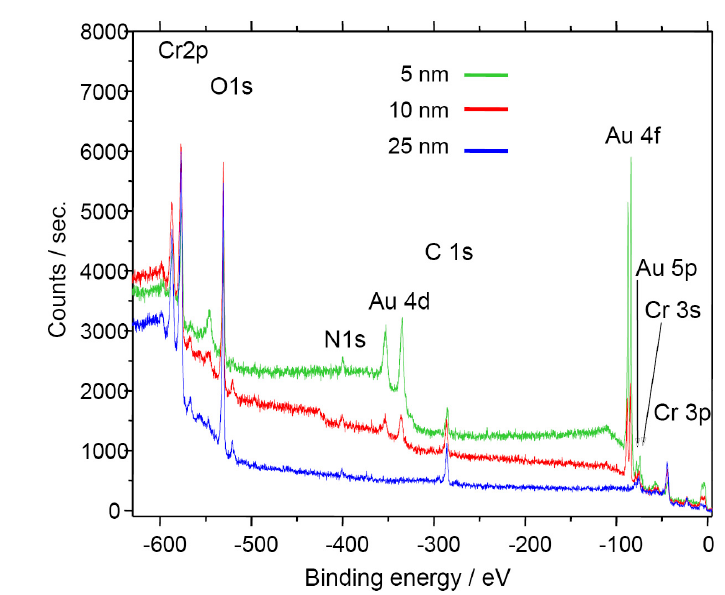
Figure 3. XPS spectra of the electrode surface of 100 nm thick gold IDE on chromium thin films with different thicknesses after heating to 450 °C (6 h). Obviously, a closed chromium oxide film on